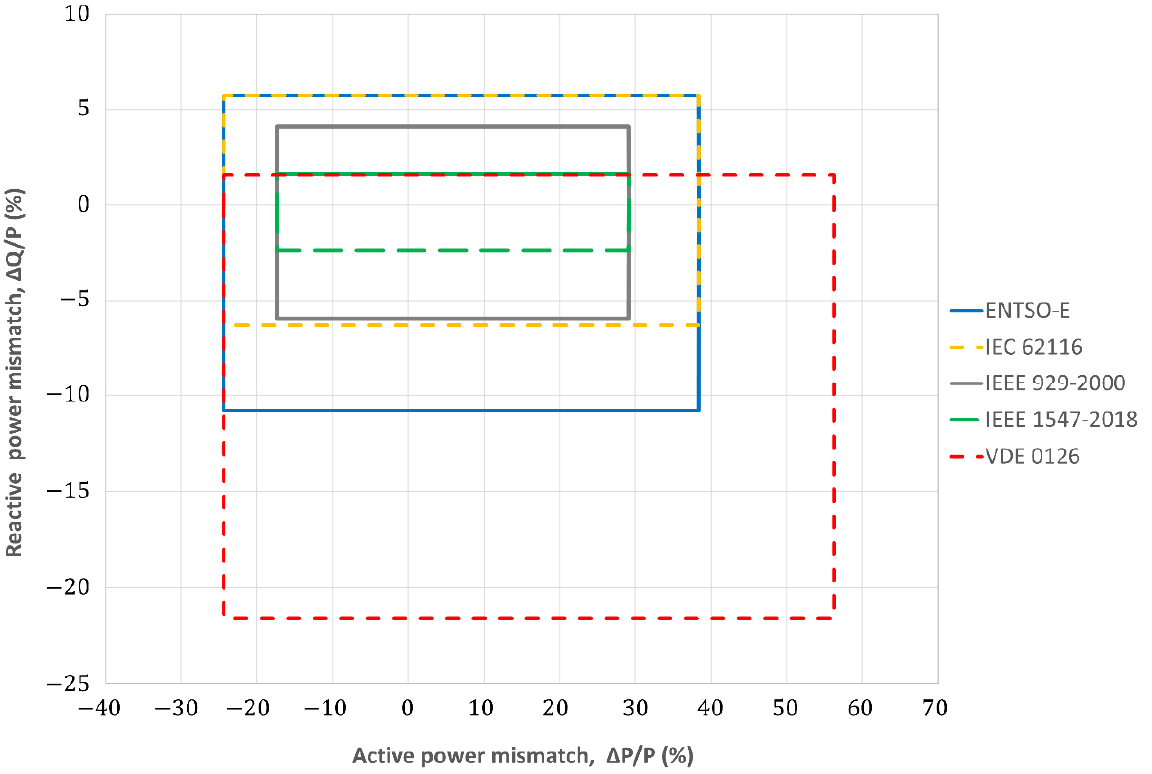
Figure 11. NDZ comparison of the NDZ of islanding standards and ENTSO-E for OUV and OUF. Both Equations (8) and (9), are derived for ∆ P = ∆ Q = 0. Therefore, when ∆ P and ∆ Q are different of zero, that is when there is a load mismatch between the AC power sources and the RLC load (calculated at the resonant frequency for Q f = 1). To show the accuracy of the approach, the value obtained from (8) and (9) are compared in Figure 12 with those of the simulation (case of inductive load). Hence, Equations (8) and (9) give a simple way to estimate the NDZ with acceptable accuracy.